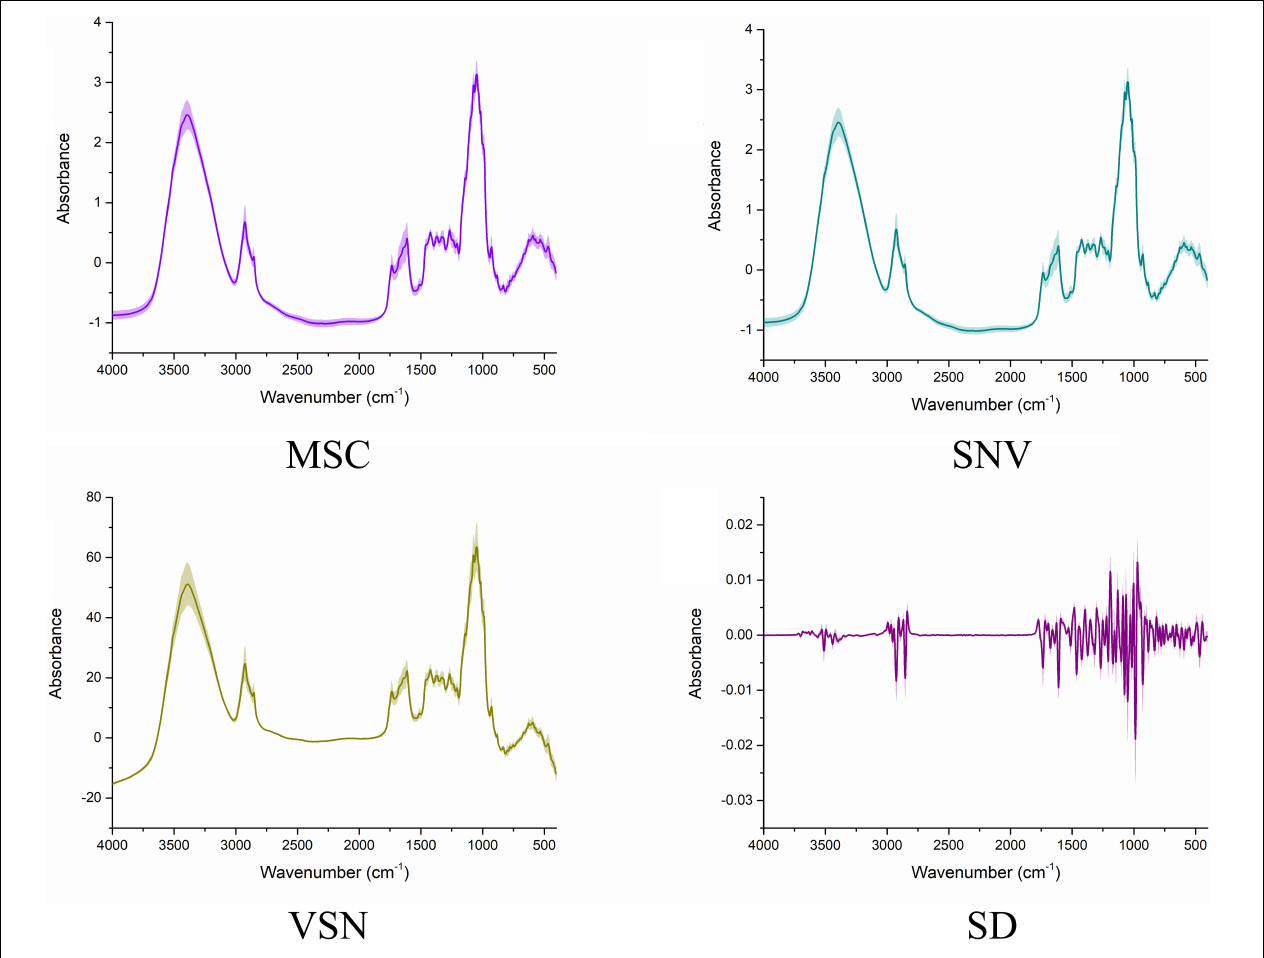
FIGURE 3 | The FT-IR spectra processed by the four scatter correction techniques. The line represents the average spectra of wild G. rigescens , and the shade around the average spectra represents the standard deviation.